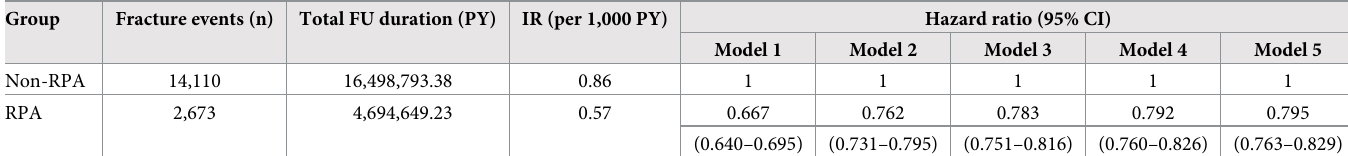
Table 2. Risk of hip fracture according to regular physical activity in the National Health Insurance Service cohort screened in 2011 and 2012. Group Fracture events (n)